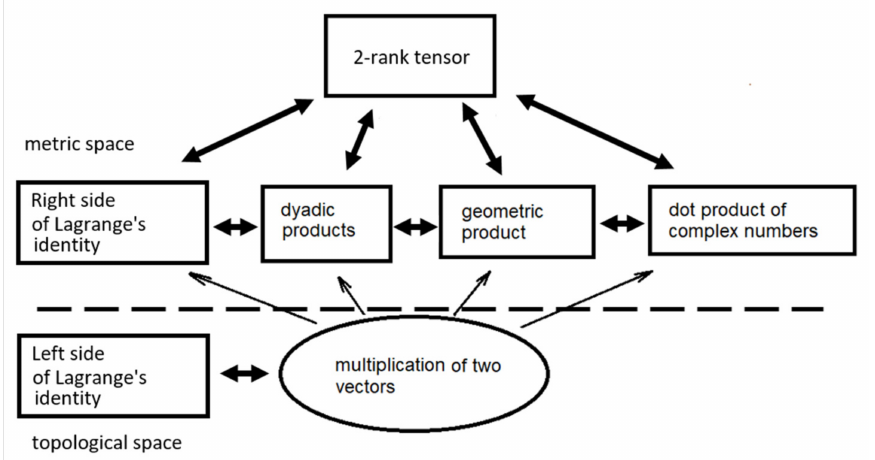
Figure 3. Relationships transformability in a 2D